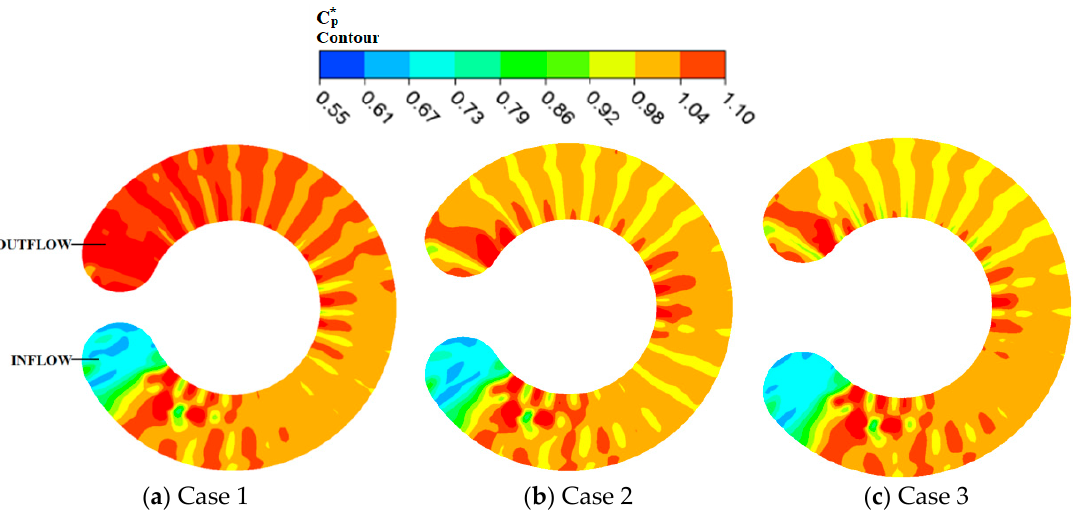
Figure 9. Pressure fluctuation intensity of side channel passage for three pump cases on plane 2.